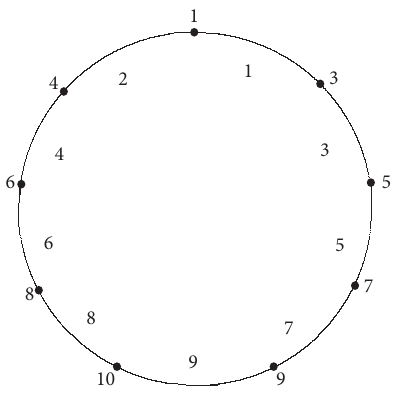
Figure 2: A classical mean labeling of C